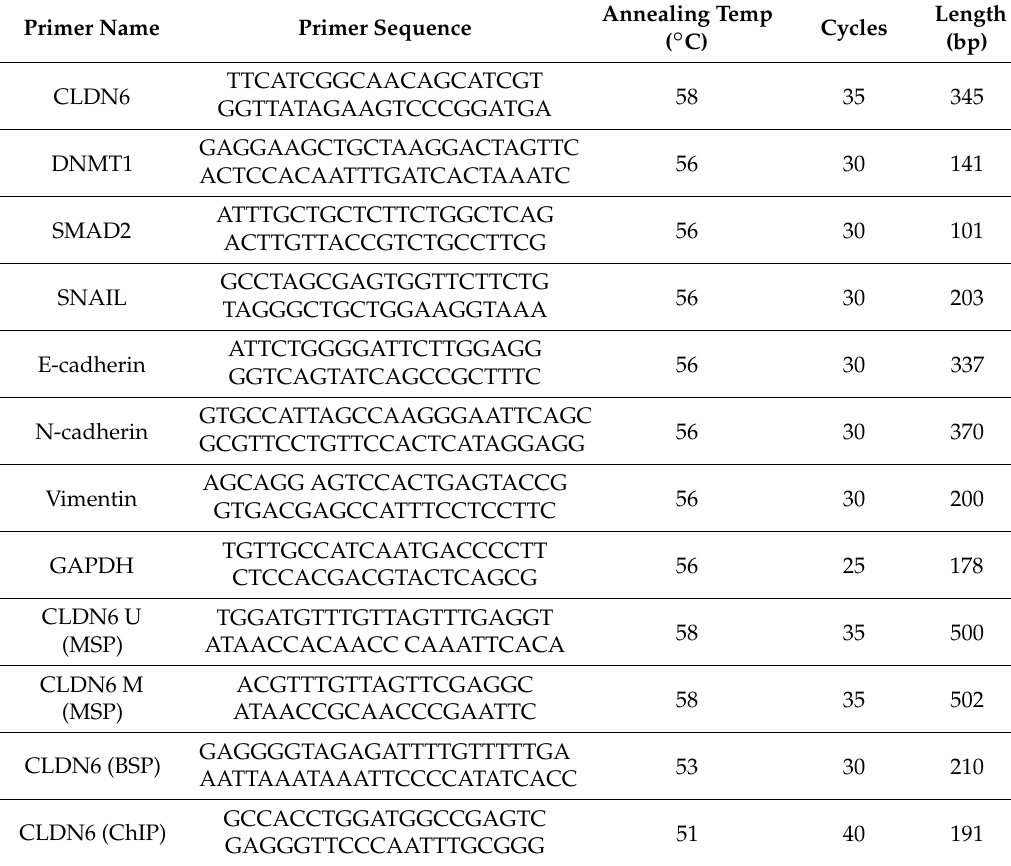
Table 1. Details of primers used for real-time polymerase chain reaction (RT-PCR), methylation-specific PCR (MSP), and chromatin immunoprecipitation (ChIP)